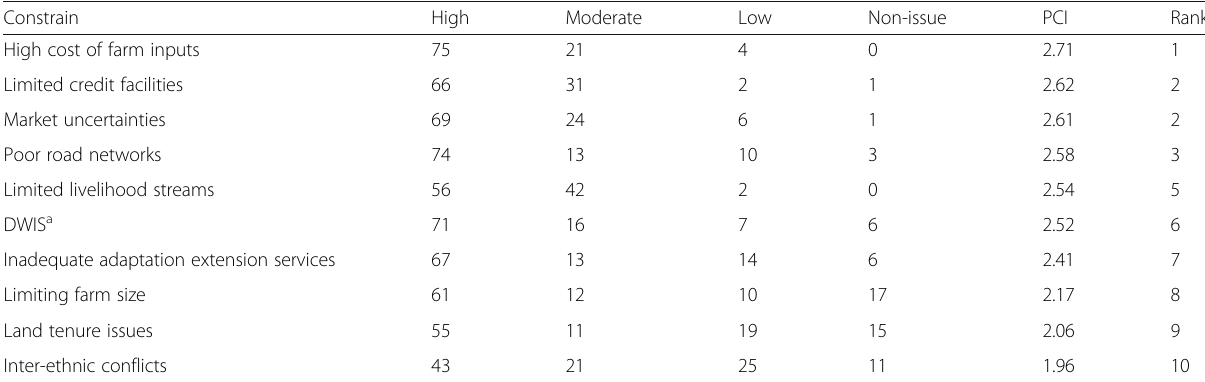
Table 4 Key challenges constraining smallholders from taking up adaptation measures against climate variability in Trans-Mara East ( N = 100) Constrain